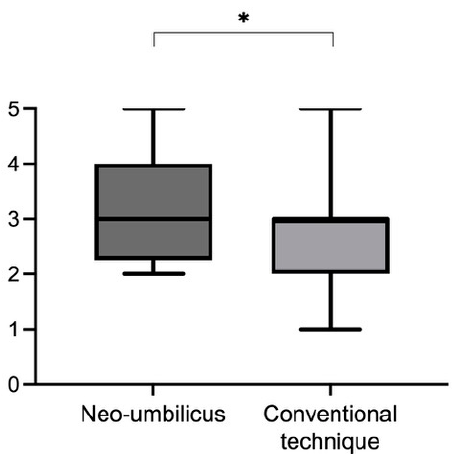
Figure 4. Rating of a panel of plastic surgeons. The rating was done on a scale from 1 to 5, with 1 being a poor result and 5 being a very good result. The neo-umbilicus scored significantly better. The mean result for the new technique was 3.3 (5-2, SD 1.069) compared to 2.667 (5-1, SD 1.095) for the conventional technique. This difference between techniques was significant ( * p = 0.016).